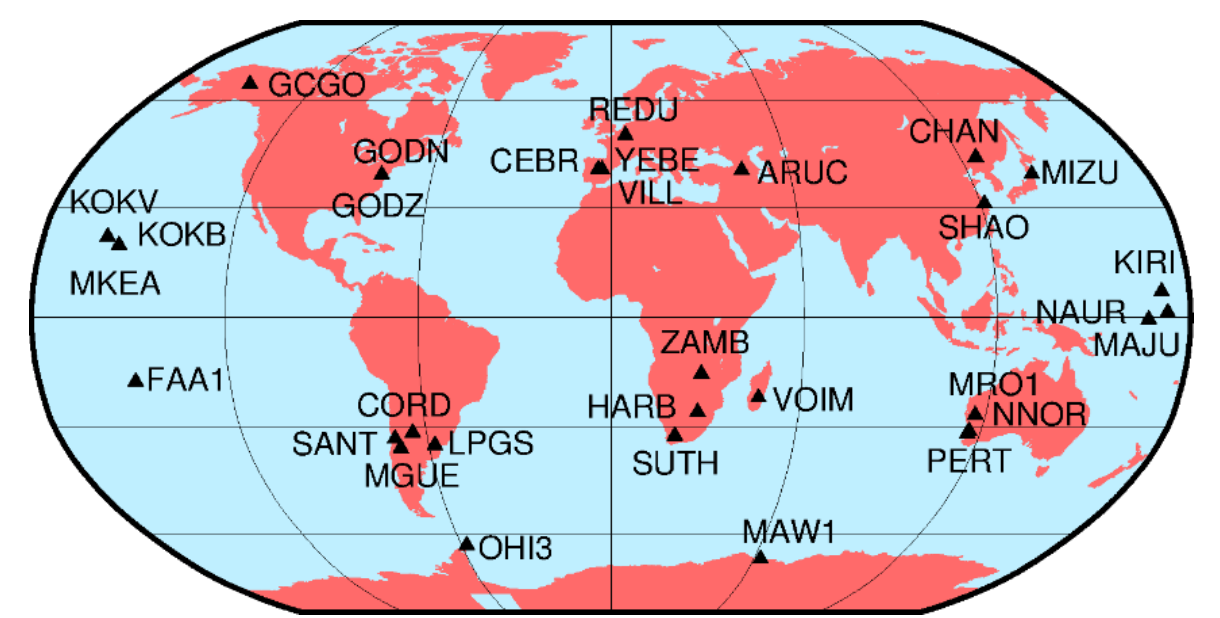
Figure 1. Location of the selected International GNSS Service (IGS) sites.